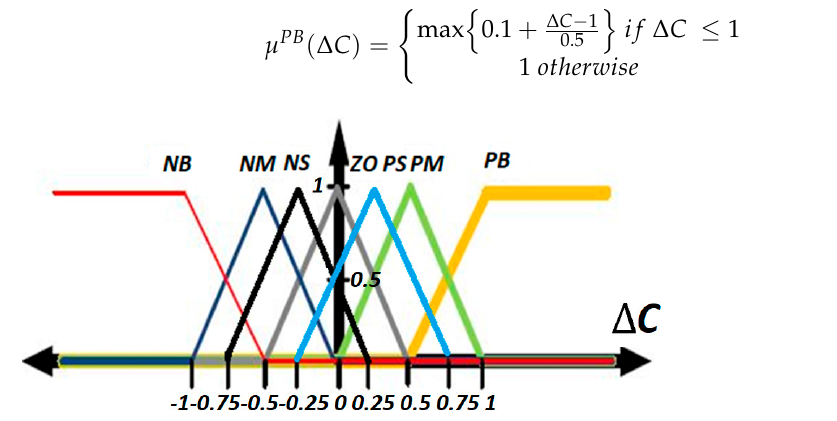
Figure 14. Exit membership Δ C. The P-V characteristics of the PV panel could be divided in five regions (with 5 points power operations), depending on the value of the absolute power slope—S a (see Figure 15). The FLC controller will cause the change to a new step; Δ C—exit member- ship is based on the old disturbance—C old to reach the MPP.